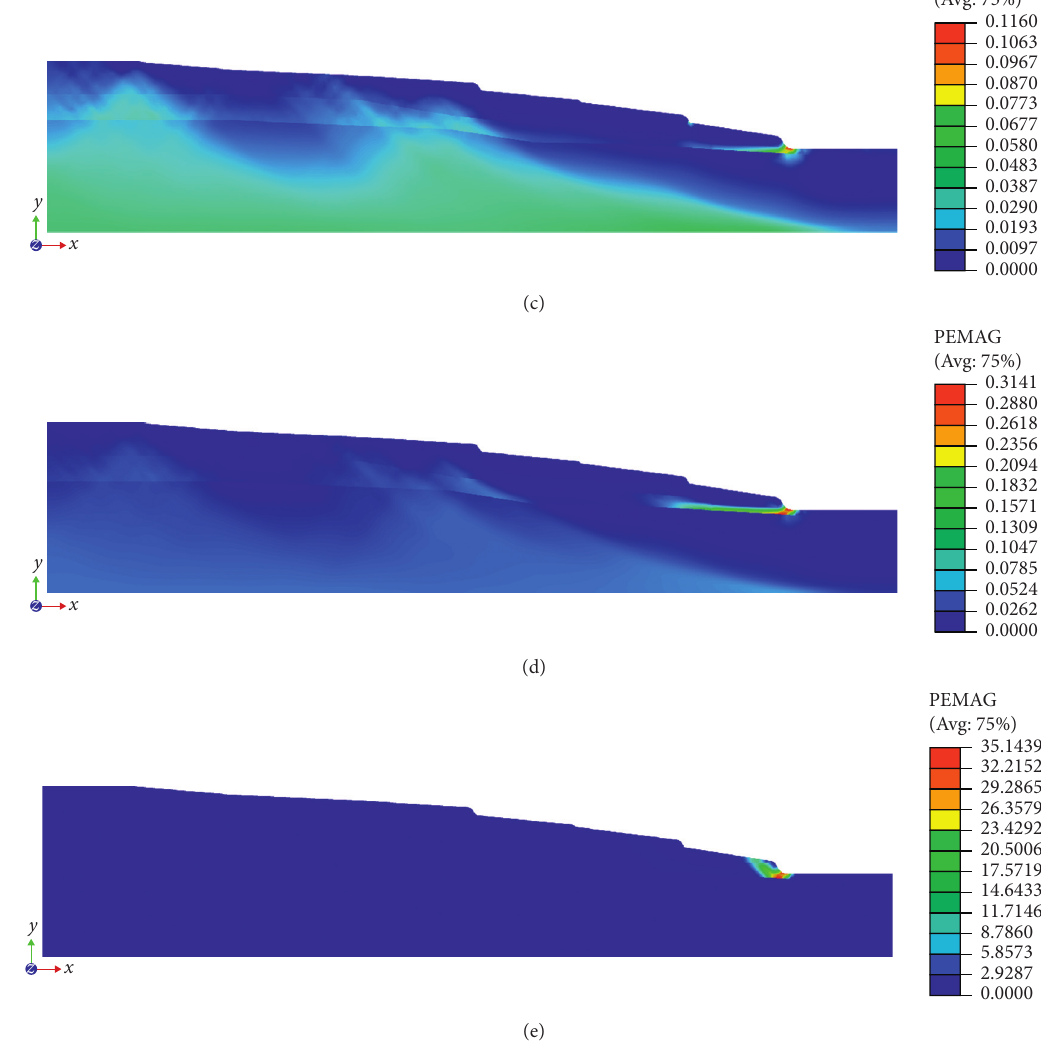
Figure 11: Plastic strain magnitudes at different times. (a) The first winter (FS � 1.38); (b) the first summer (FS � 1.04); (c) the third summer (FS � 0.80); (d) the sixth summer (FS � 0.70); (e) the ninth summer (FS � 0.65). Table 4: The factor of safety of the slope at different